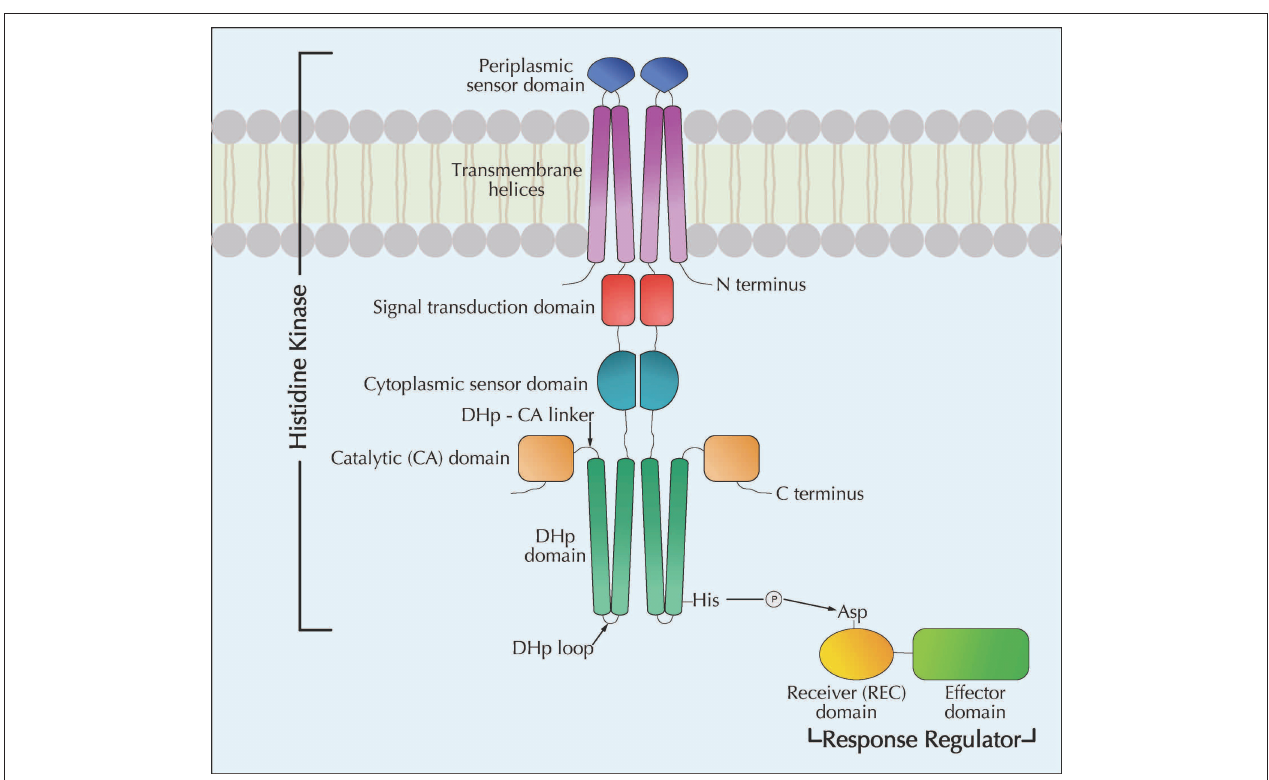
FIGURE 1 | Schematic diagram showing the cellular architecture of a typical two-component regulatory system as well the mechanism of phosphotransfer between two components (modified with permission from Springer Nature Du et al., 2018. A prototypical TCS, comprised of a membrane-bound sensory h istidine k inase (HK) and a cytosolic r esponse r egulator (RR) protein, is shown. The basic mechanism of a TCS involves the HK sensing the environmental changes and relaying the message to the RR effectively through phosphorelays to initiate the necessary response. HK proteins, usually dimers, possess several conserved domains that are essential for their function, such as d imerization and h istidine p hosphotransfer (DHp) domain and c atalytic A TP binding (CA) domain which make up the catalytic core of the HK ( Bhate et al., 2015). The H-box containing the conserved histidine residue, that gets phosphorylated, is located in the DHp domain (Casino et al., 2009, 2010). The CA domain binds ATP and phosphorylates the histidine residue, thus initiating the HK autophosphorylation (Zschiedrich et al., 2016). The DHp and CA domains are conserved among all HK proteins and the sensory domains are variable conferring specificity of signal recognition. The phosphoryl group from the H-box of the HK is ultimately transferred to a conserved aspartate residue of the receiver (REC) domain of the cognate RR thus activating the RR (Yamamoto et al., 2005). While the REC domain is highly conserved, the effector domains of RR display variability conferring specificity to the protein (Zschiedrich et al., 2016). Following its activation, dephosphorylation of the RR is critical to maintain the efficient regulatory capacity of the TCSs ( Kenney, 2010). This is achieved through the phosphatase activity of the HK (Hsing and Silhavy,